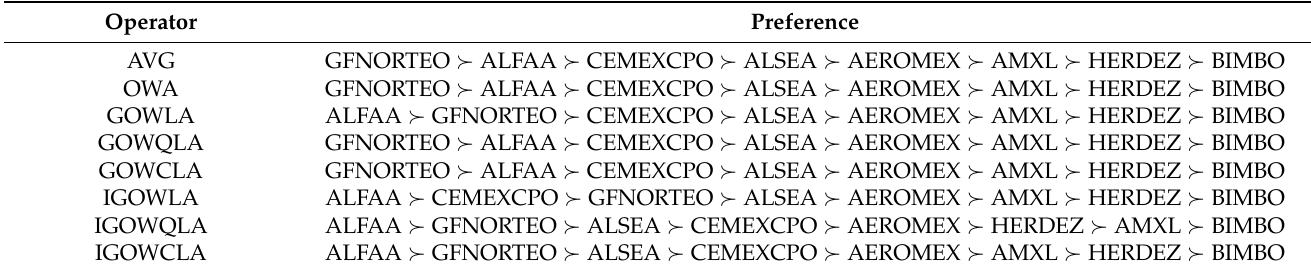
Table 6. Ranking based on highest